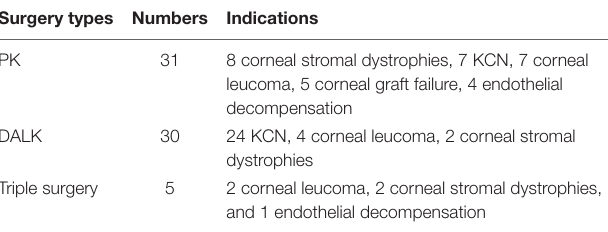
TABLE 1 | Distribution of preoperative indications and surgery